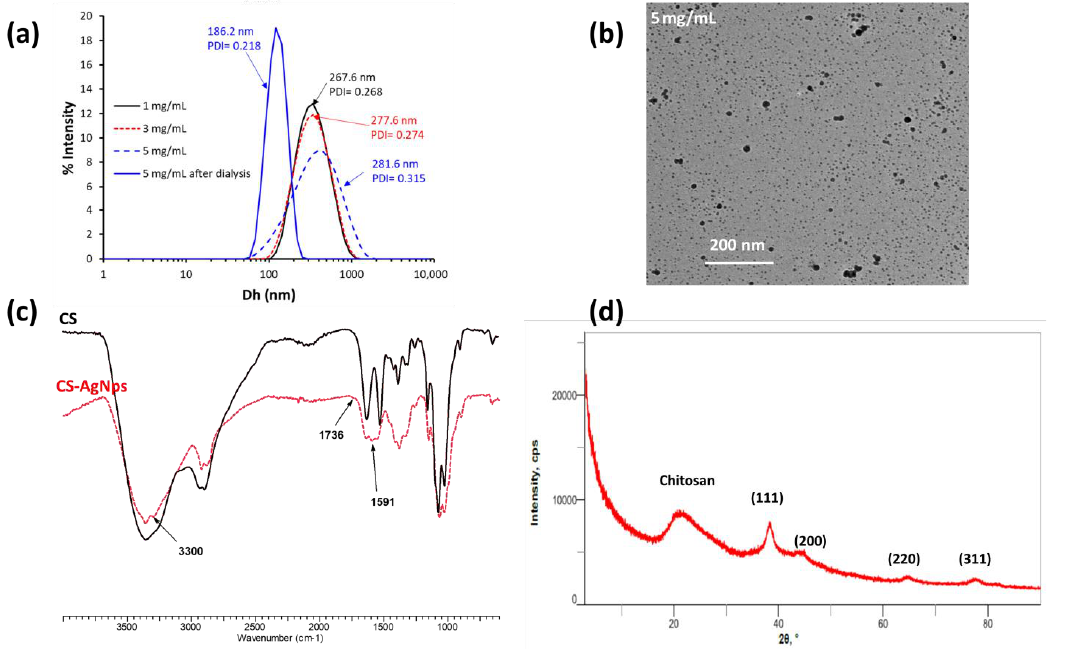
Figure 2. Size distribution (measured by DLS) of CS-AgNps synthesized using different CS concen- trations ( a ) and TEM images ( b ); FT-IR spectra ( c ) and XRD spectrum ( d ) of CS-AgNps (experimental conditions: (CS) = 5 mg/mL, (AgNO 3 ) = 70 mM; 90 °C; 17 h).